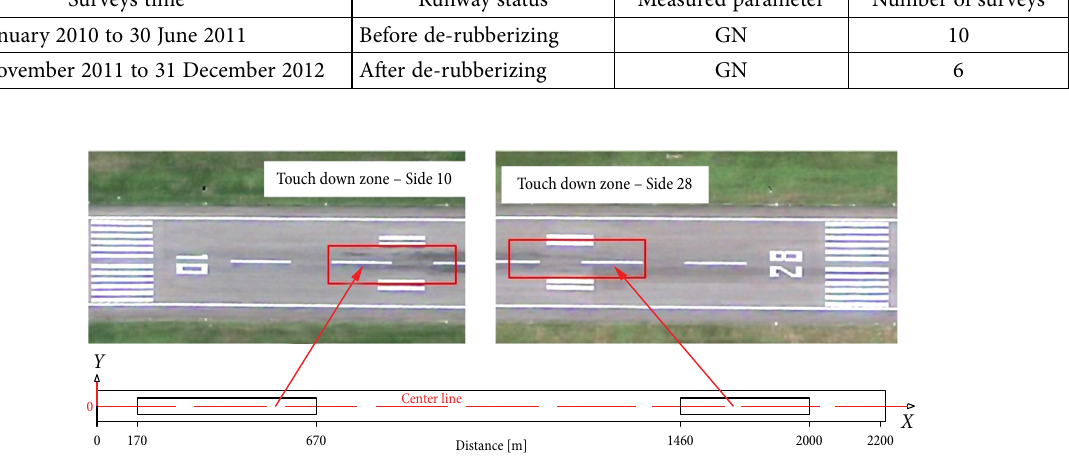
Fig. 3. Layout of GN survey Table 1. GN surveys timetable before and after runway de-rubberizing Surveys time Runway status Measured parameter